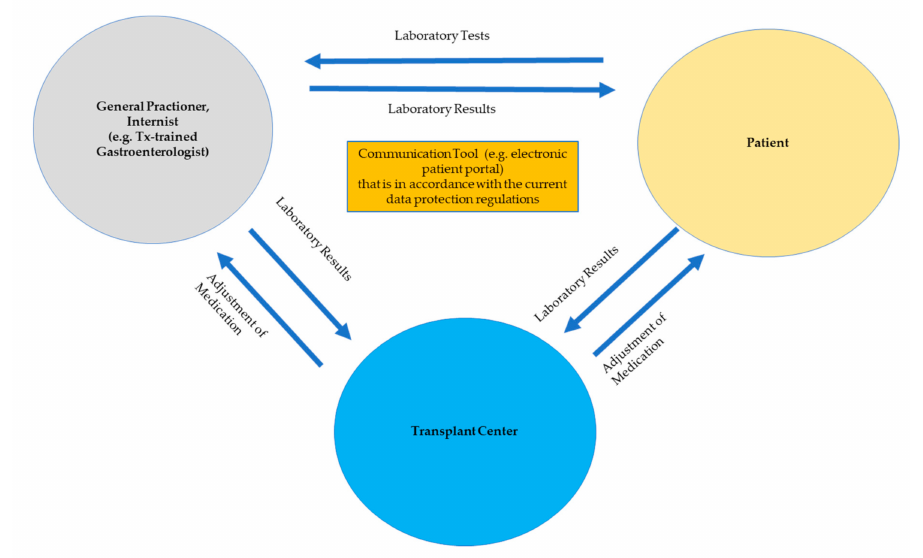
Figure 5. Challenging intersectoral communication and